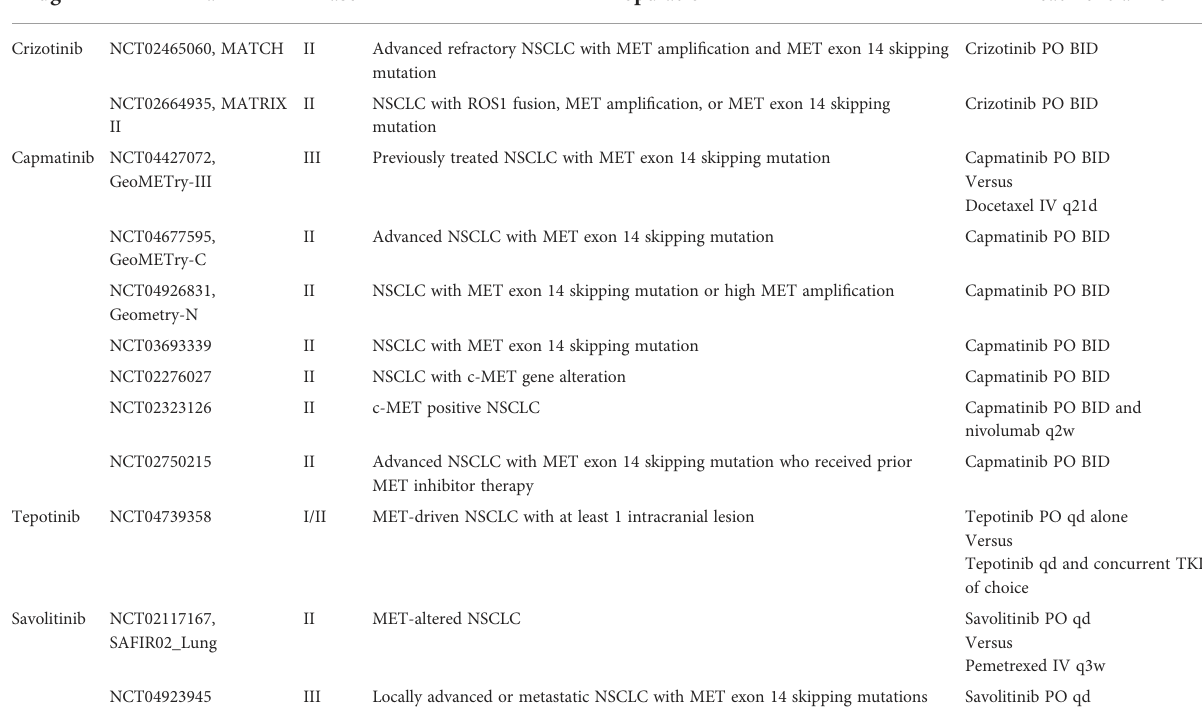
TABLE 2 Active Trials of Type I MET